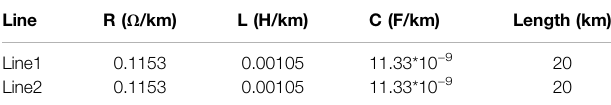
TABLE A3 | Parameters of the transmission